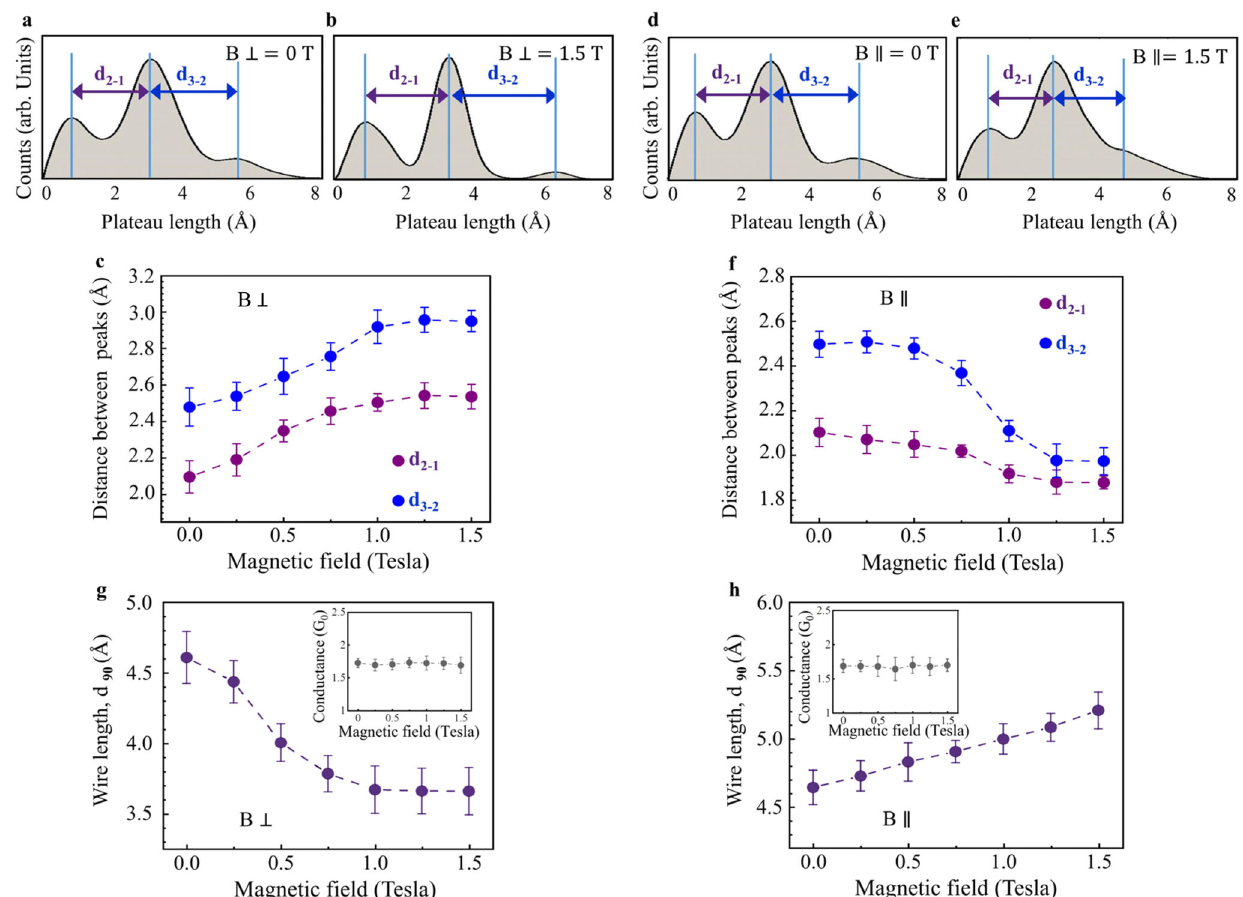
applied perpendicular to the junction ’ s axis, respectively, as de fi ned in Fig. 1a. d 2-1 and d 3-2 are the inter-peak distances, which provide an indication for the distance is 20.5±0.6% for d 2-1 and 18.9± 0.4% for d 3-2 . d , e Similar to ( a , b ), but with an applied magnetic fi eld parallel to the junction ’ s axis, as de fi ned in Fig.1a. f Similartoc,but witha parallel magnetic fi eld.Here,the overallreductionintheinter-peak distance asa functionofparallel magnetic fi eld is10.5±0.6% for d 2-1 and 20.5±0.6% for d 3-2 . g , h d 90 , a measureofthewirelength, asa function of perpendicular ( g ) and parallel ( h ) magnetic fi eld.Perpendicular